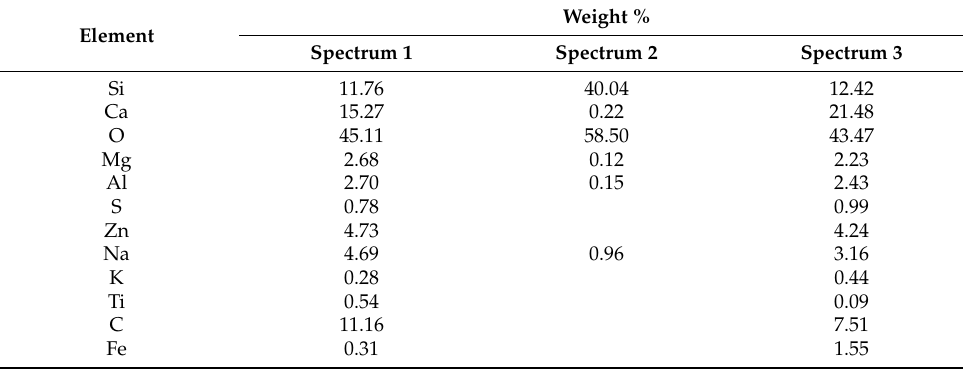
Figure 9. The image of ZK1 grain sand with the remains of the binder with the indicated places of chemical microanalysis. Table 9. The chemical composition in the microareas indicated in Figure 9.